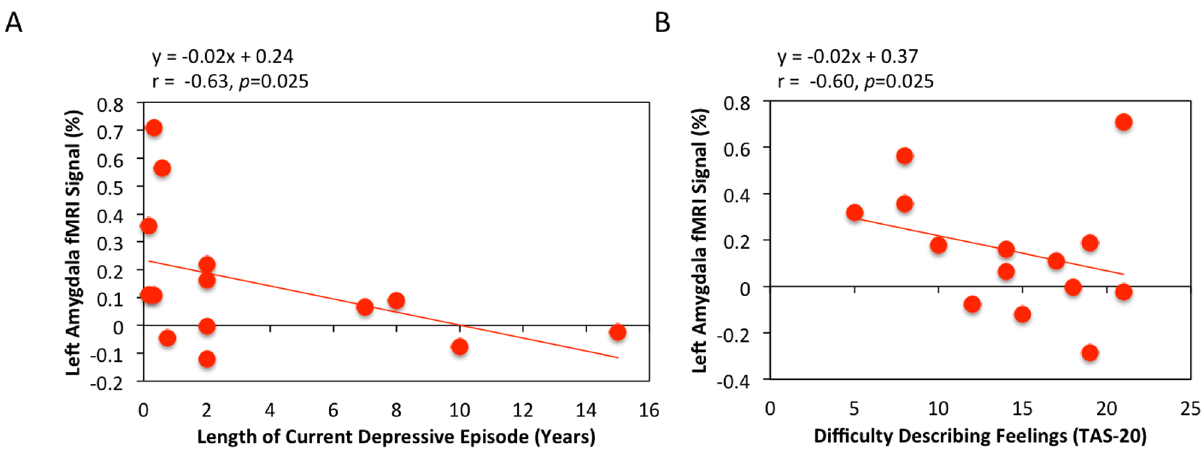
Figure 3. Relationship between left amygdala neurofeedback training effect and individual characteristics in the experimental rtfMRI-nf group. A) Correlation with length of the current major depressive episode. The training effect for the left amygdala (the average Happy – Rest percent signal change over the three training runs) was inversely correlated with the length of participants’ current depressive episode. B) Correlation with difficulty describing feelings (TAS-20). The more difficulty a participant had describing their own feelings, the less average BOLD activation for the Happy-Rest contrast was observed in the left amygdala for the three training runs.